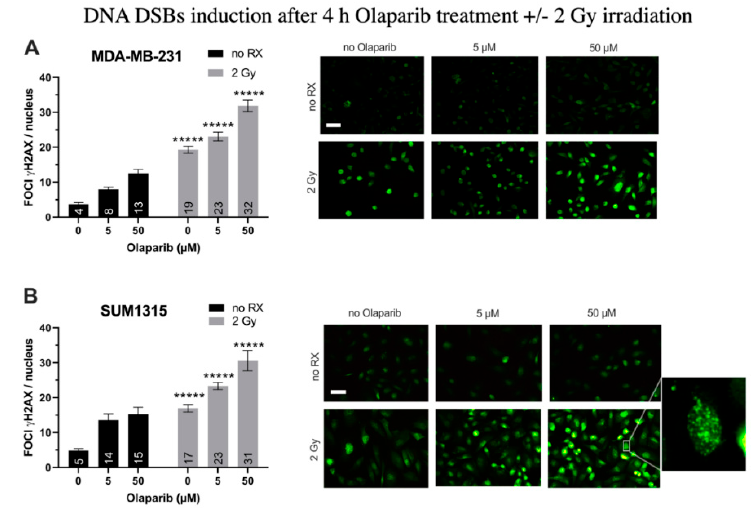
Figure 1. DNA Double Strand Breaks (DSBs) induction in MDA-MB-231 ( A ) and SUM1315 ( B ) cell lines cultured in monolayer after a treatment with 0.1% DMSO (control cells), 5 and 50 µ M Olaparib for 4 h alone (no irradiation “no RX” ) or combined with 2 Gy of irradiation (4 h and 2 Gy). The number of foci gammaH2AX per cell in > 10 fields per condition was determined with ImageJ software. Results are represented as mean number of foci gammaH2AX per nuclei with their standard deviation. A student t -test was performed for statistical comparison of all treatment conditions, where ns = non-significant and ***** p < 0.00001. Magnification = 40 × , scale bar = 50 µm.